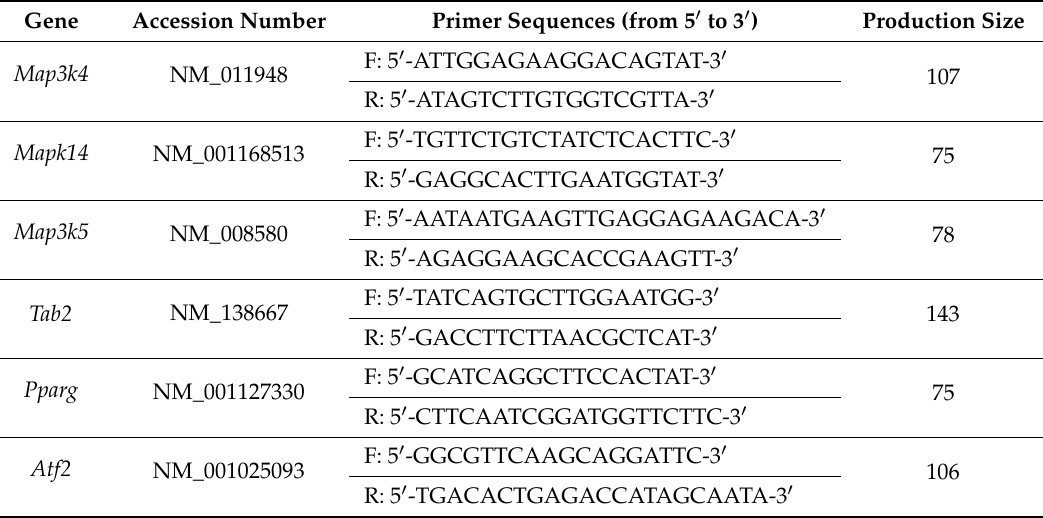
Table 2. Primer using in real time